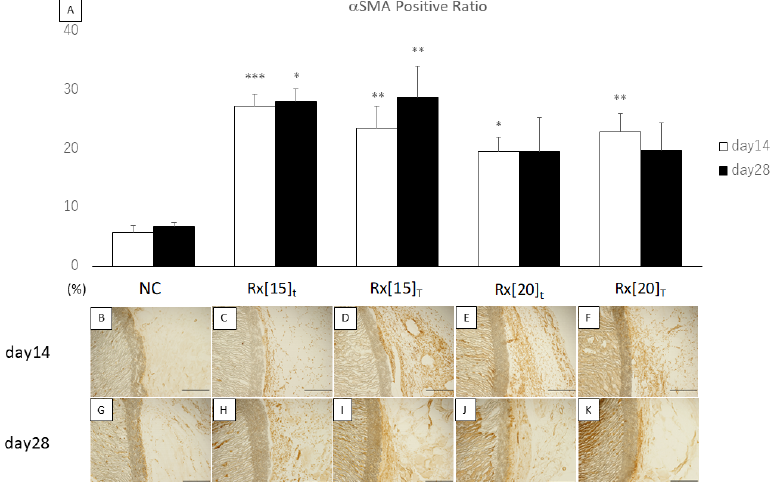
Figure 6. α -smooth muscle actin ( α SMA)-stained sections after implantation of radiation-crosslinked hydrogel (RXgel)-coated expanded polytetrafluoroethylene (ePTFE) vascular grafts: ( A ) Expression ratio of α SMA was analyzed using α SMA staining. The significance compared to non-coated ePTFE on the same day is shown by asterisks (* p < 0.05, ** p < 0.005, *** p < 0.0005); ( B – K ) α SMA staining of 5-mm-thick sections on days 14 and 28 after implantation of each RXgel-coated ePTFE graft. In each picture, the outer surface of the ePTFE graft is in the center and at the right side of the graft wall. The α SMA-positive areas are shown in dark brown. Each scale bar indicates 100 µ m. We also compared the quantitative results of the Col-III positive ratio with those of the NC group on the same day. On day 14, only Rx[15] t showed significantly higher expression of Col-III compared to the NC, whereas on day 28, both Rx[15] t and Rx[15] T showed significantly higher expression of Col-III compared to the NC (Figure 7).